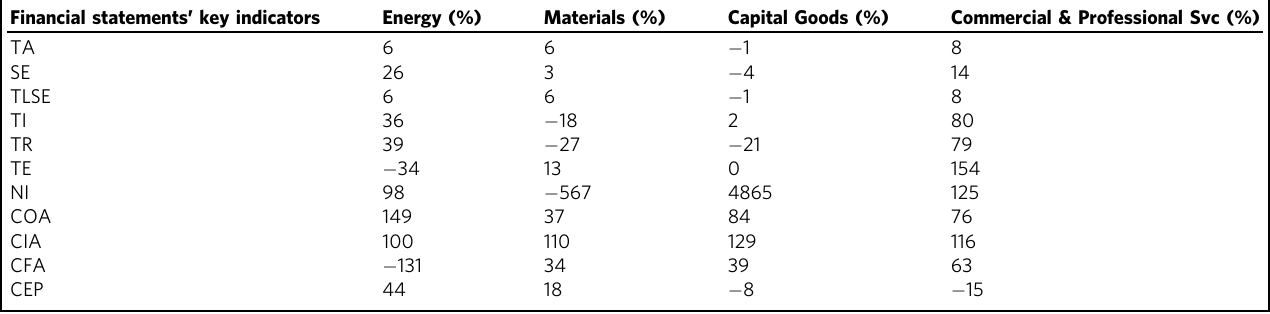
Table 4 increase or decrease in values of fi nancial statements ’ key indicators in terms of the average between Energy, Materials, Capital Goods, and Commercial & Professional Svc industries.